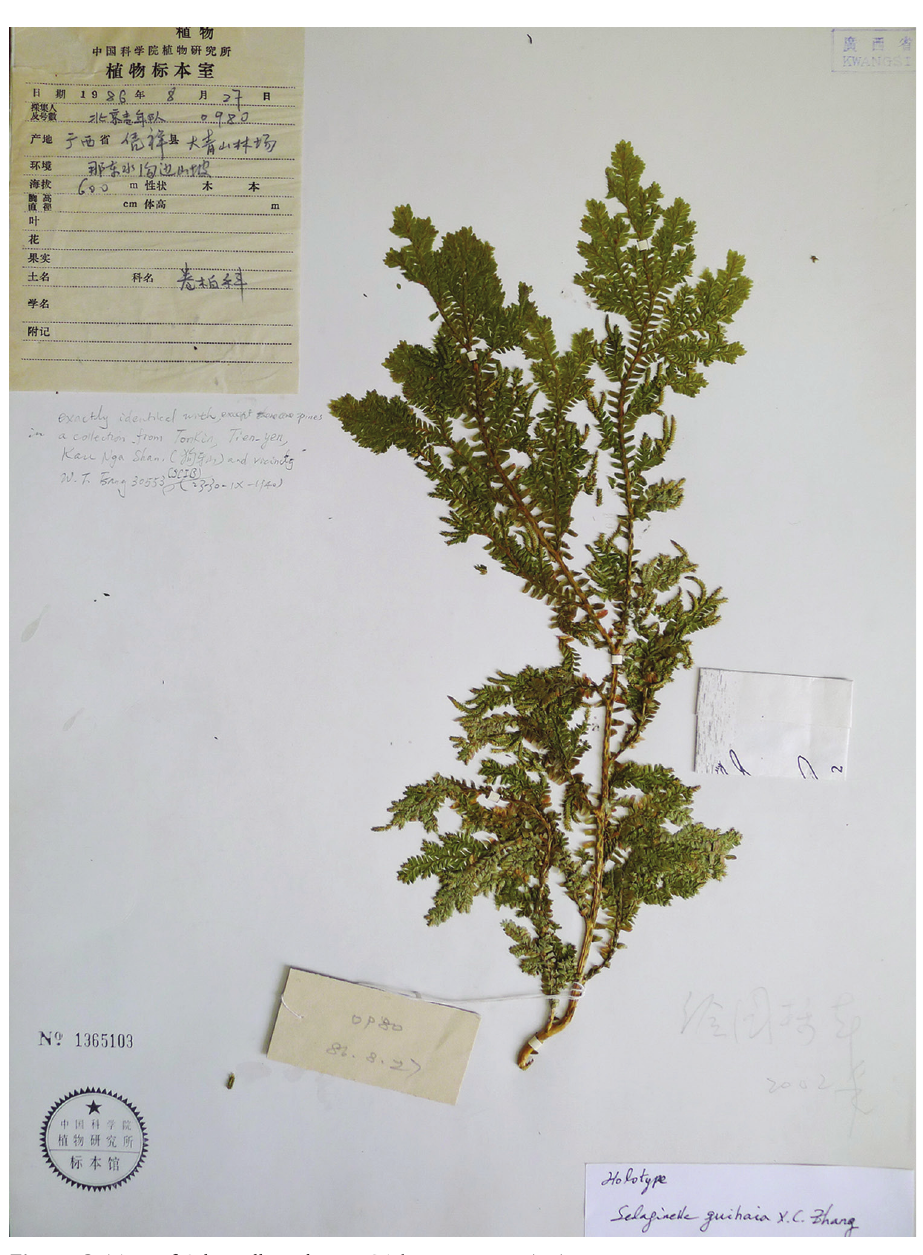
Figure 3. Type of Selaginella guihaia X.C.Zhang, sp. nov. (PE).